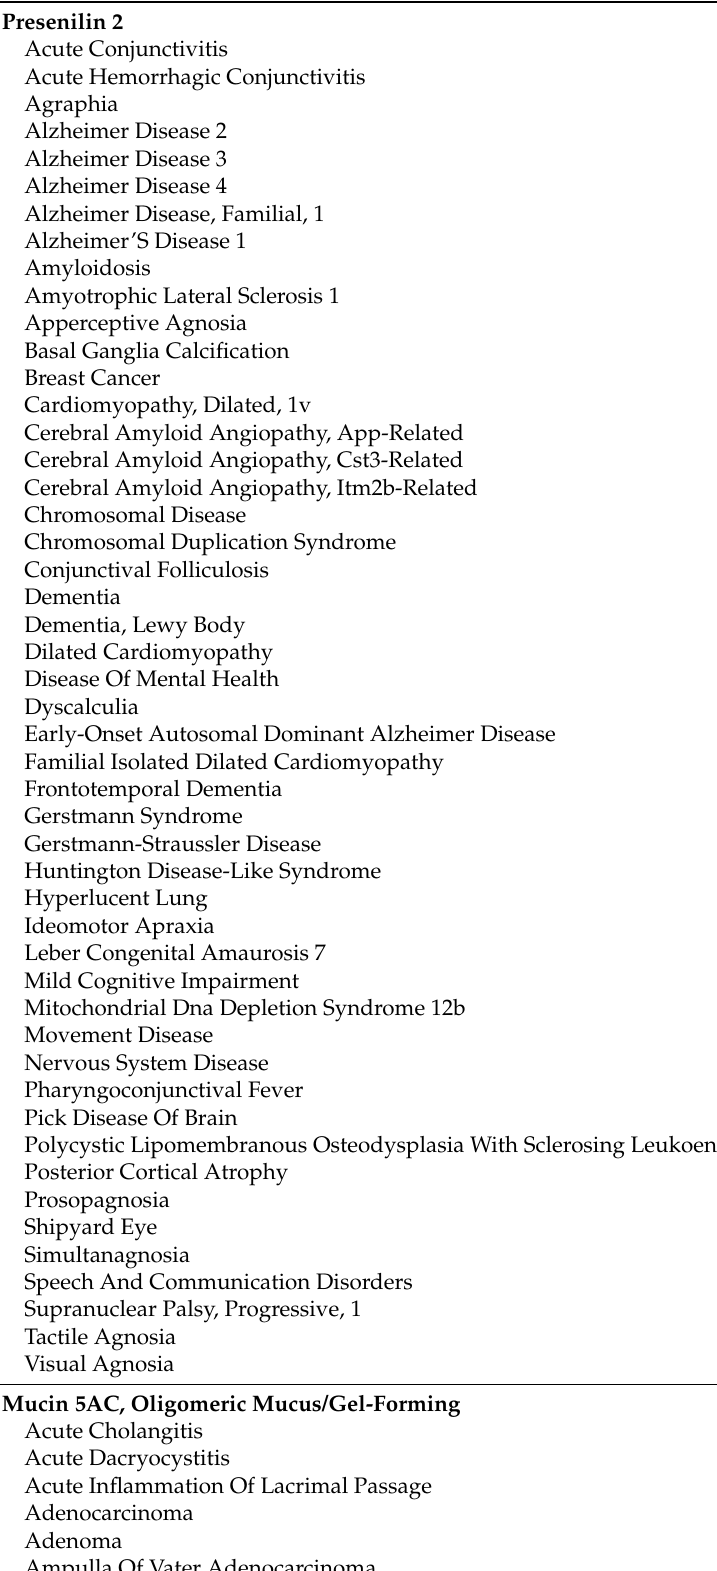
Table A1. Cont. Presenilin 2 Acute Conjunctivitis Acute Hemorrhagic Conjunctivitis Agraphia Alzheimer Disease 2 Alzheimer Disease 3 Alzheimer Disease 4 Alzheimer Disease, Familial, 1 Alzheimer’S Disease 1 Amyloidosis Amyotrophic Lateral Sclerosis 1 Apperceptive Agnosia Basal Ganglia Calcification Breast Cancer Cardiomyopathy, Dilated, 1v Cerebral Amyloid Angiopathy, App-Related